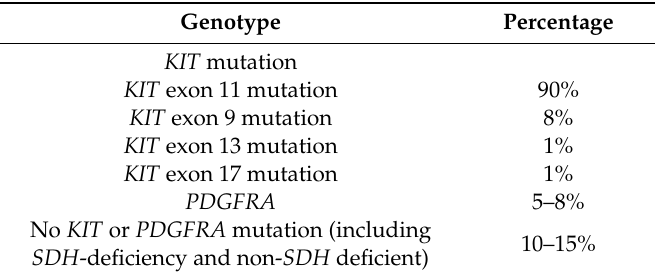
Table 2. Summary of genotypes in